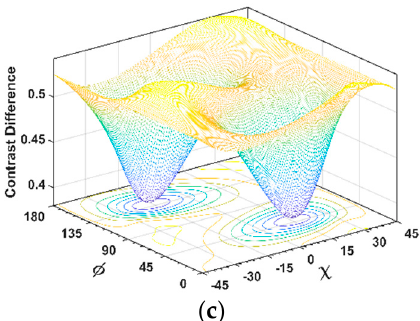
Figure 7. Polarimetric TomoSAR focusing capability for cell B: ( a ) Four-data stack, ( b ) nine-data stack, ( c ) polarization TomoSAR dispersion obtained through the subtraction of ( b ) from ( a ).